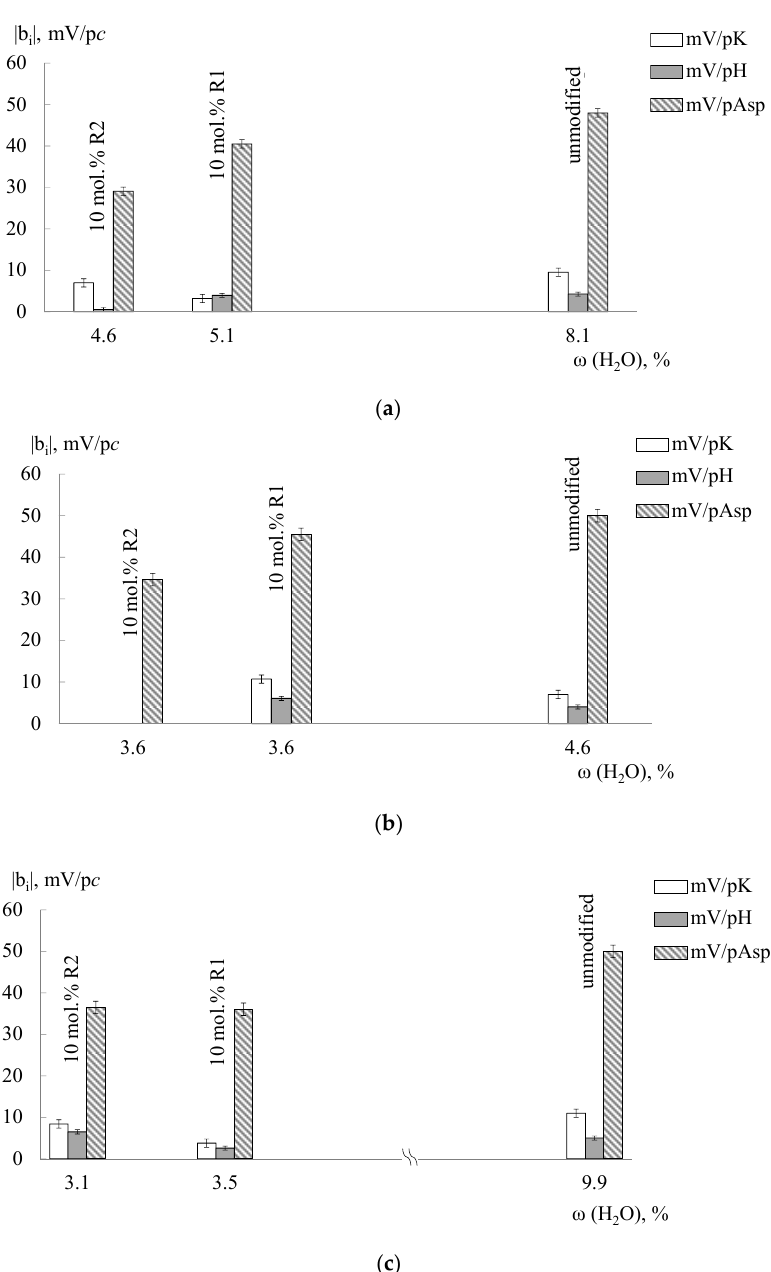
Figure 6. The dependence of DP-sensors’ sensitivity coefficients to ions in the Asp + KOH solutions (pH 3.99–8.20) on the water uptake (in the K + -form) of MF-4SC (extrusion) ( a ) and Nafion (extrusion) ( b ) membranes: 1—RH = 60%, t = 95 °C; 2—mechanical deformation of 80%, t = 80 °C; 3—initial sample; 4—t ht = 120 °C.